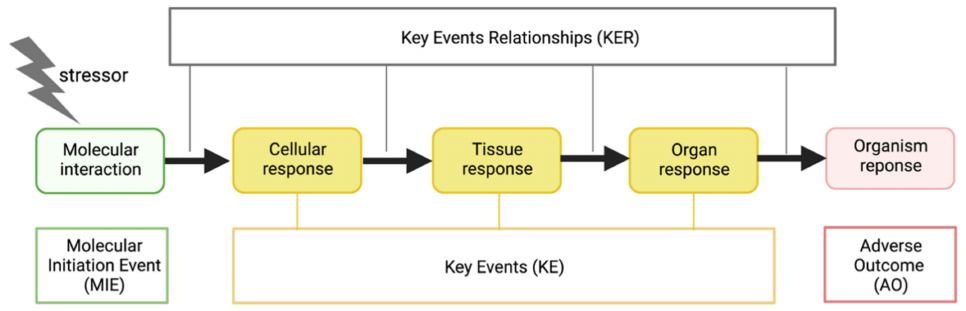
Figure 1. An AOP describes a sequential chain of causally linked events at different levels of biological organization that lead to an adverse health effect. Created with Biorender.com